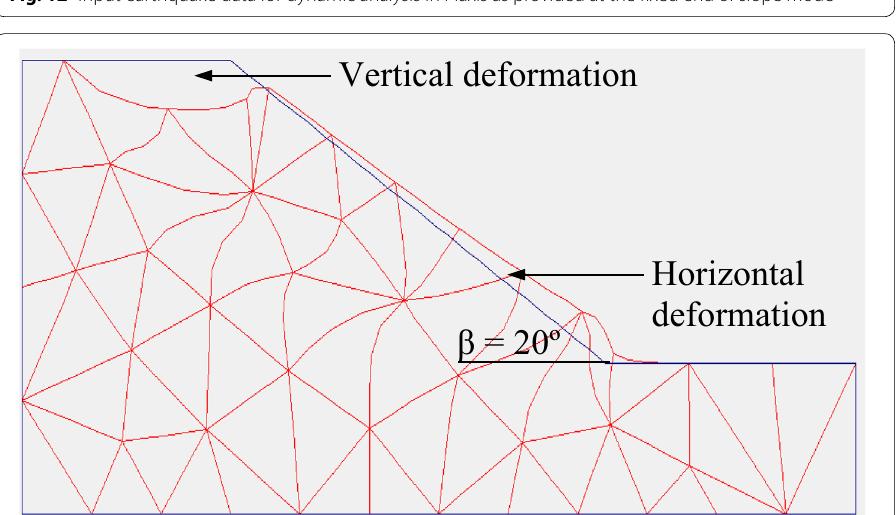
Fig. 12 Input earthquake data for dynamic analysis in Plaxis as provided at the fixed end of slope mode